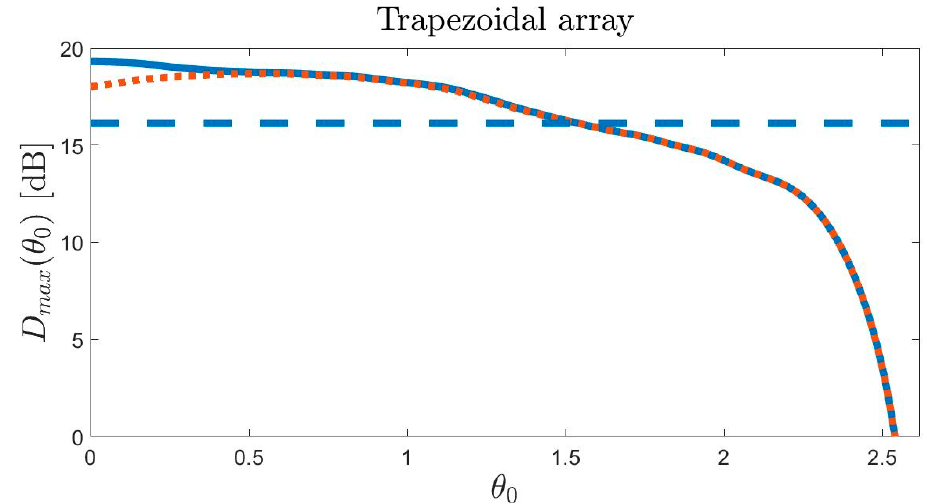
Figure 6. The behavior of the maximum directivity D max ( θ 0 ) of the trapezoidal array (solid blue line) in Figure 4 and its corresponding value of D max (dashed blue line). The dotted red line represents the maximum directivity D max ( θ 0 ) due to the only upper angle array forming the source, which specularly acts with respect to the lower angle array.